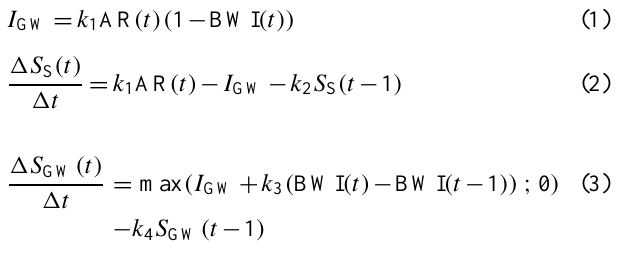
Fig. 2. The probability of rainfall event given a Soil Water Index (SWI) class and the average rainfall amount for the same classes for the three watersheds Upper Zambezi (1) , Kafue River (2) and Luangwa River (3)